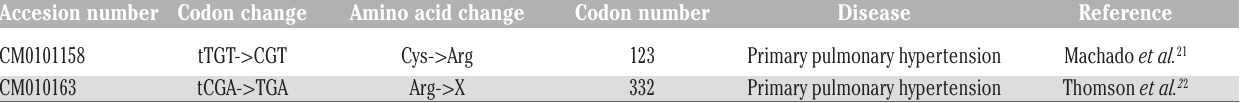
Table 3. Mutations associated with the idiopathic pulmonary arterial hypertension phenotype.